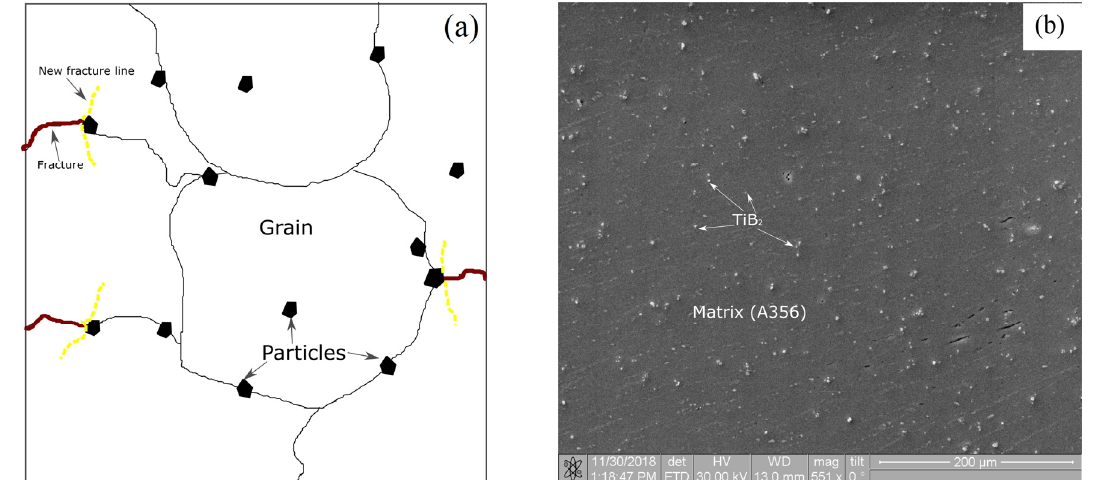
Figure 5. ( a ) Schematic design of the strengthening mechanism of aluminum alloys with the introduction of TiB 2 particles and ( b ) SEM image of the structure of the alloy A356 + 0.5 wt% TiB 2 .